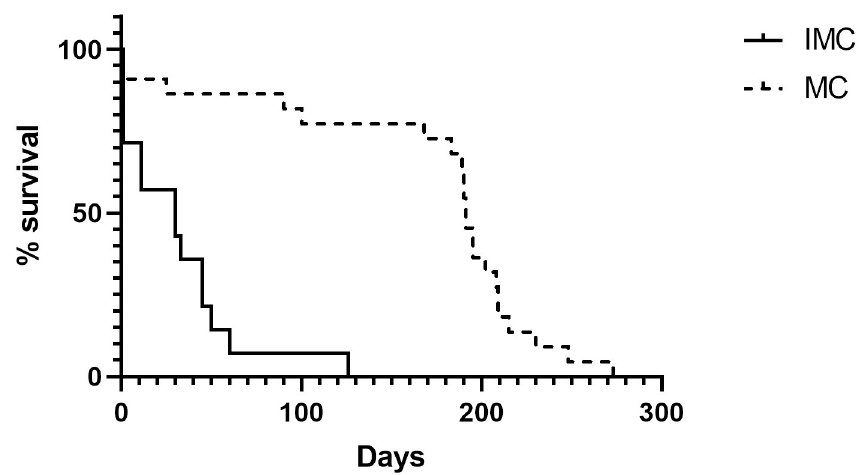
Fig 7. Survival rates of dogs with mammary carcinoma. Kaplan-Meier survival curves for animals in IMC and MC groups. Significant differences at p = 0.001 are denoted by ��� .